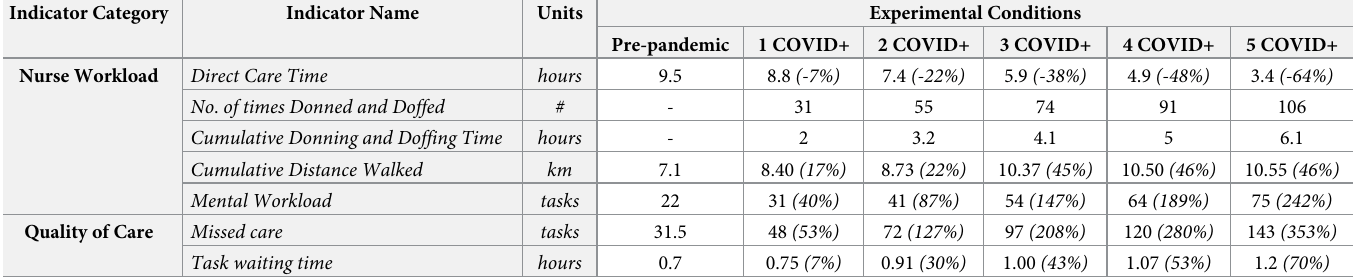
Table 3. Summary of the different experimental conditions. Where, C+ = COVID-19 positive patient and the percent change is relative to the Pre-pandemic (baseline) case. Indicator